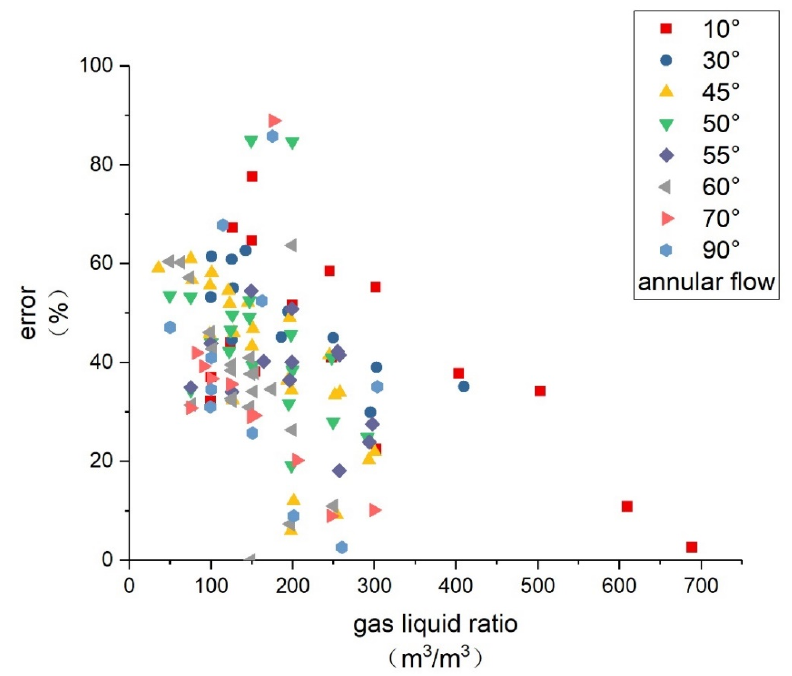
Figure 14. The error between calculated values and actual values in annular flow.